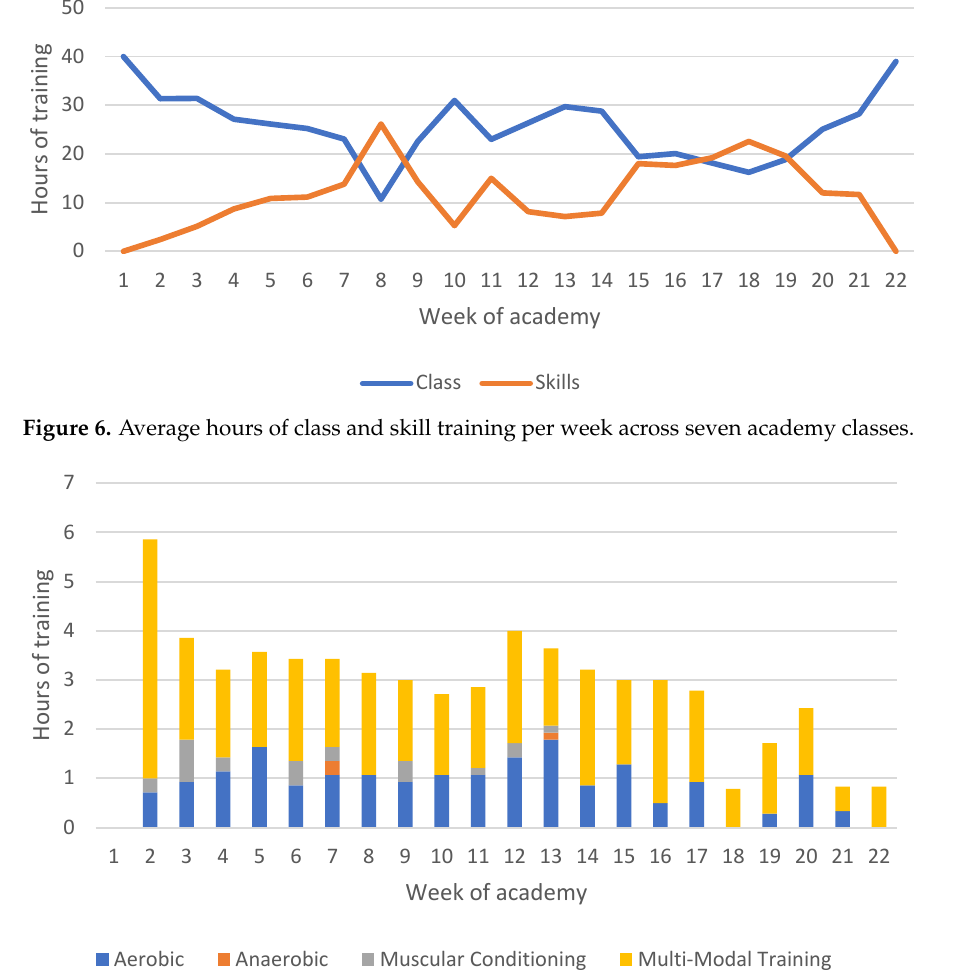
Figure 7. Average hours of training methodology per week across seven academy classes.